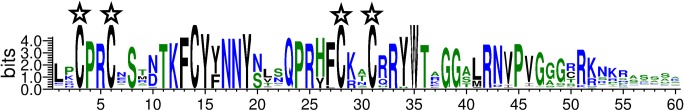
The distribution of all sugarcane Dof domains at each position.Multiple alignments of all sugarcane Dof domains were performed to plot the sequence logos with ClustalW. The information content of Dof domains at each position was indicated with the bits score. The four conserved cysteine residues of SsDof domains were indicated with the asterisks.